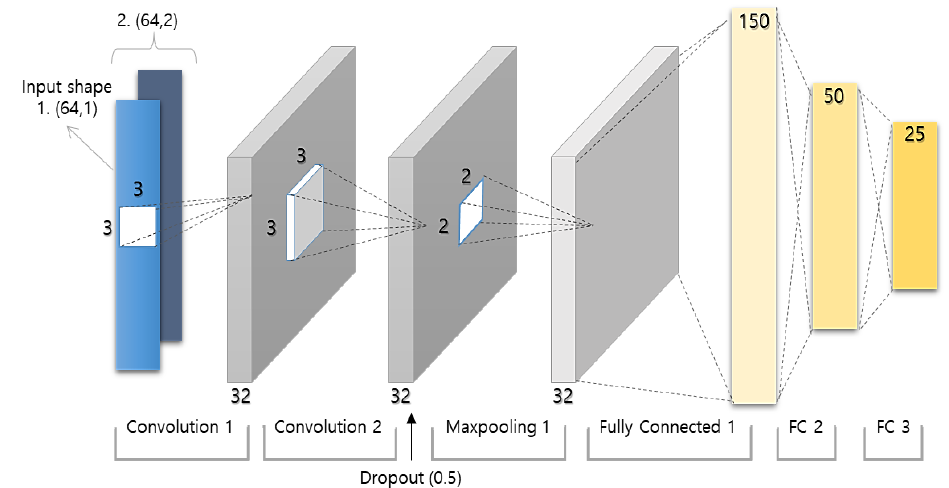
Figure 8. Proposed 1D convolutional neural network CNN model.